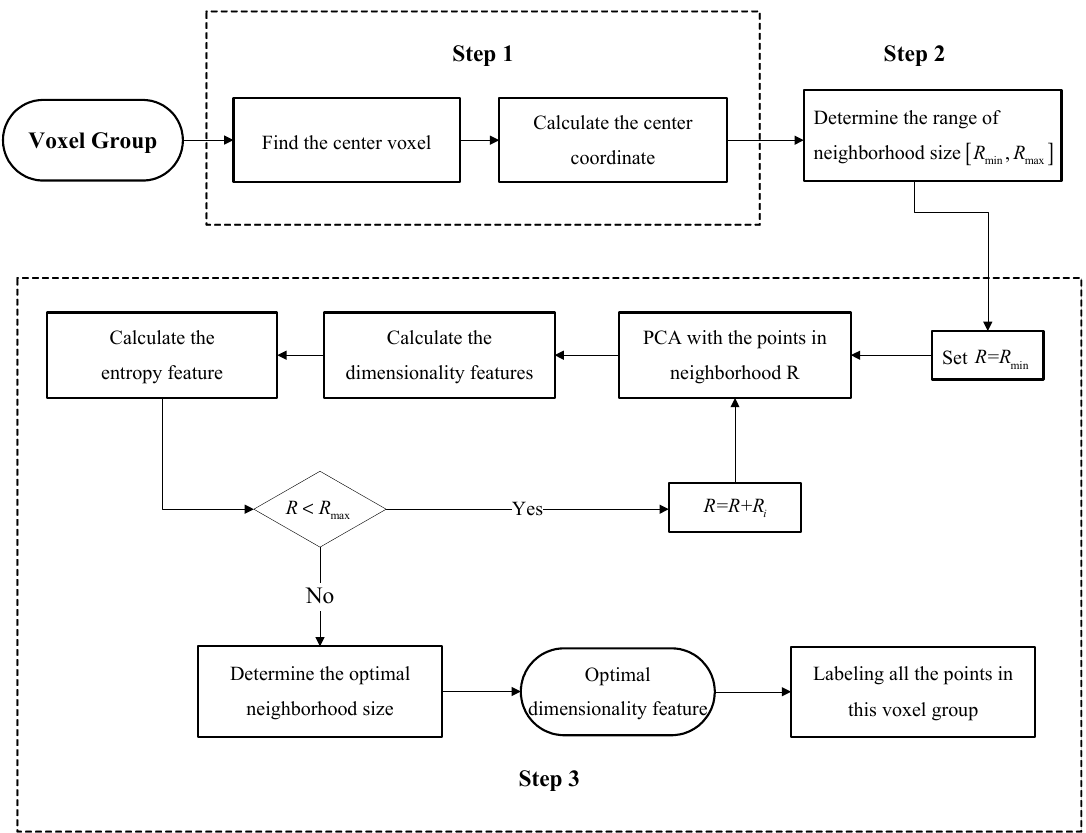
Figure 4. Flowchart of shape recognition for each voxel group.